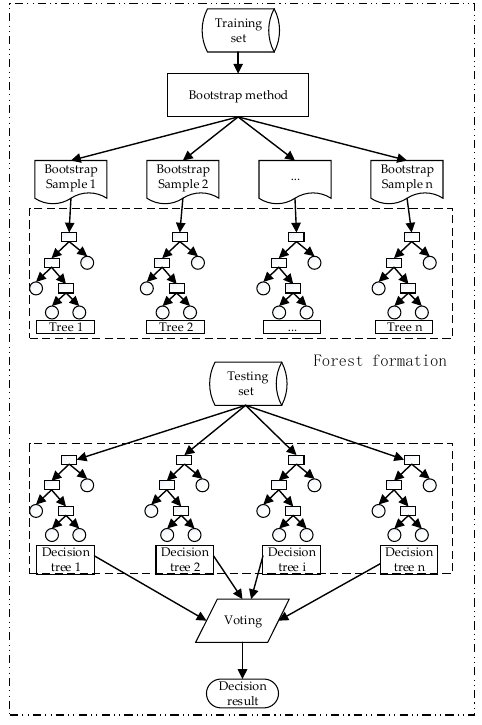
Figure 7. Schematic diagram of the random forest (RF) algorithm.